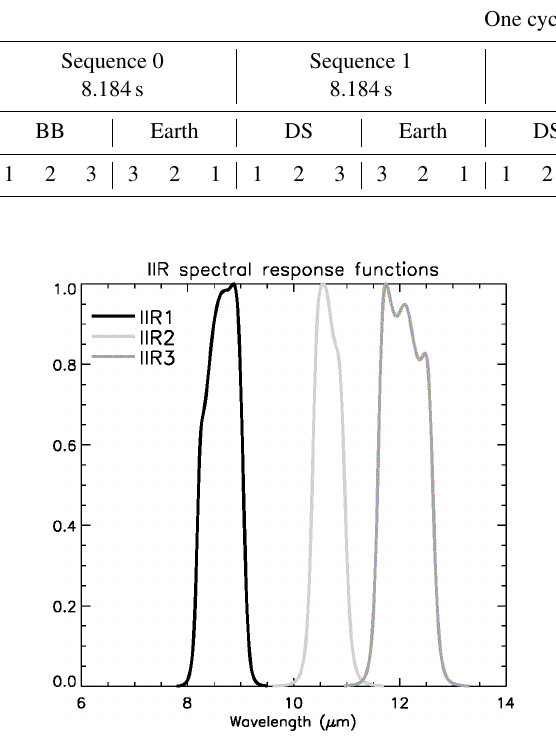
Figure 1. Spectral response functions in IIR channels IIR1 (black), IIR2 (light grey), and IIR3 (dark grey).